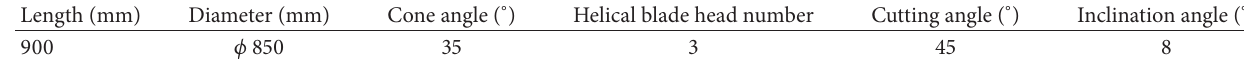
Table 2: Structure parameter of cutting head.